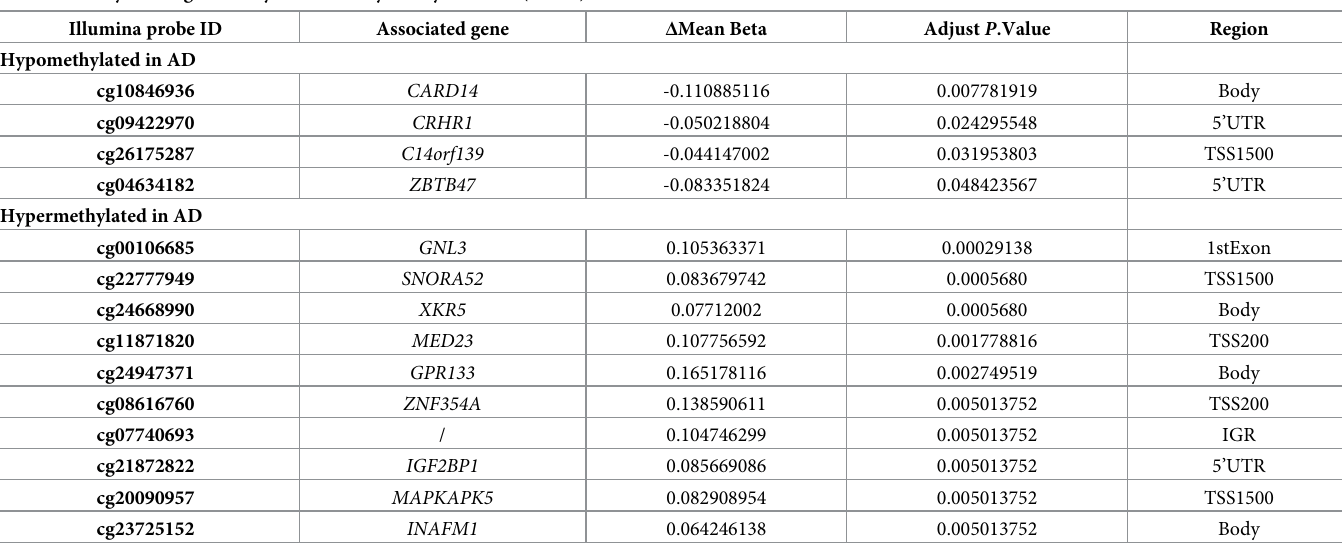
Table 2. Analysis of significantly differentially methylated loci